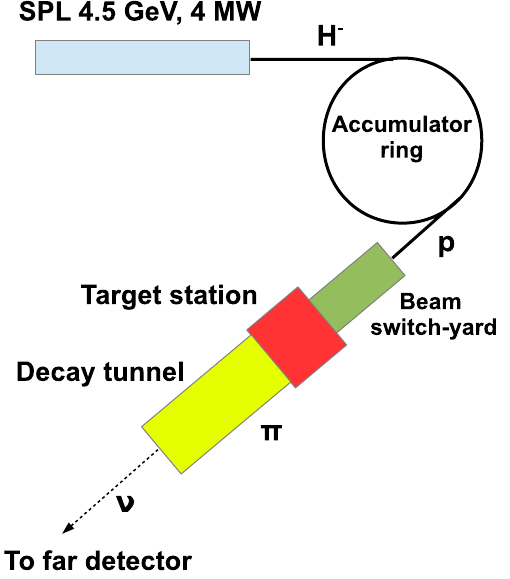
FIG. 1. Schematic view of the various components of the neutrino Super Beam.